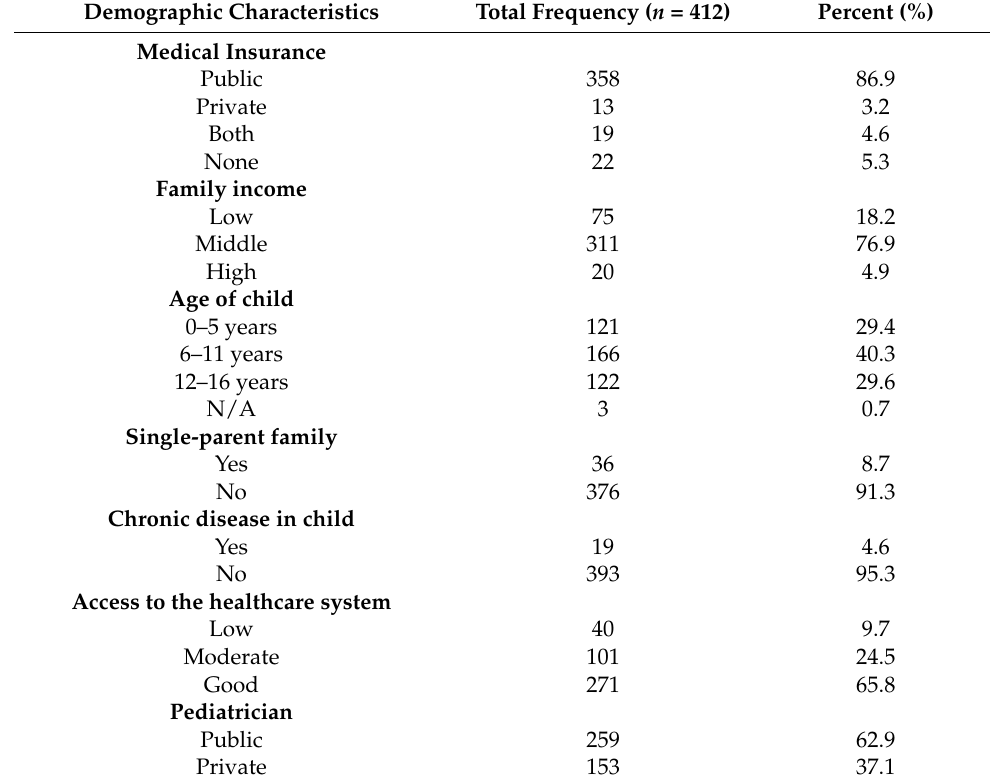
Table 1. Cont. Demographic